Question: What kind of plot is shown here?
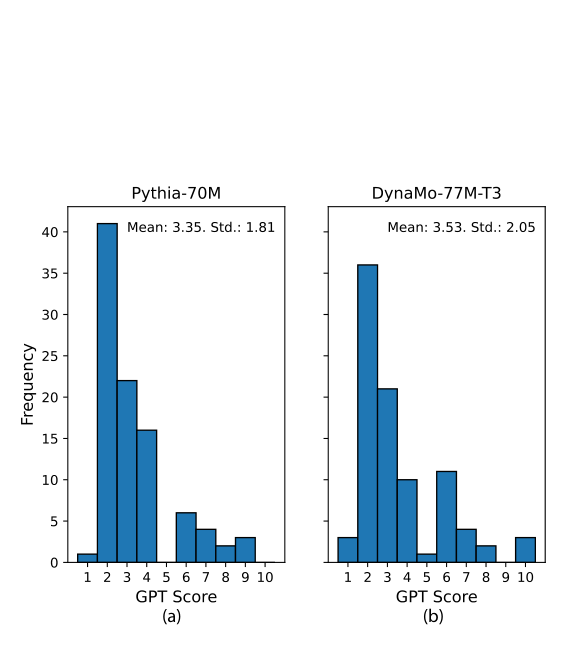
Answer: histogram